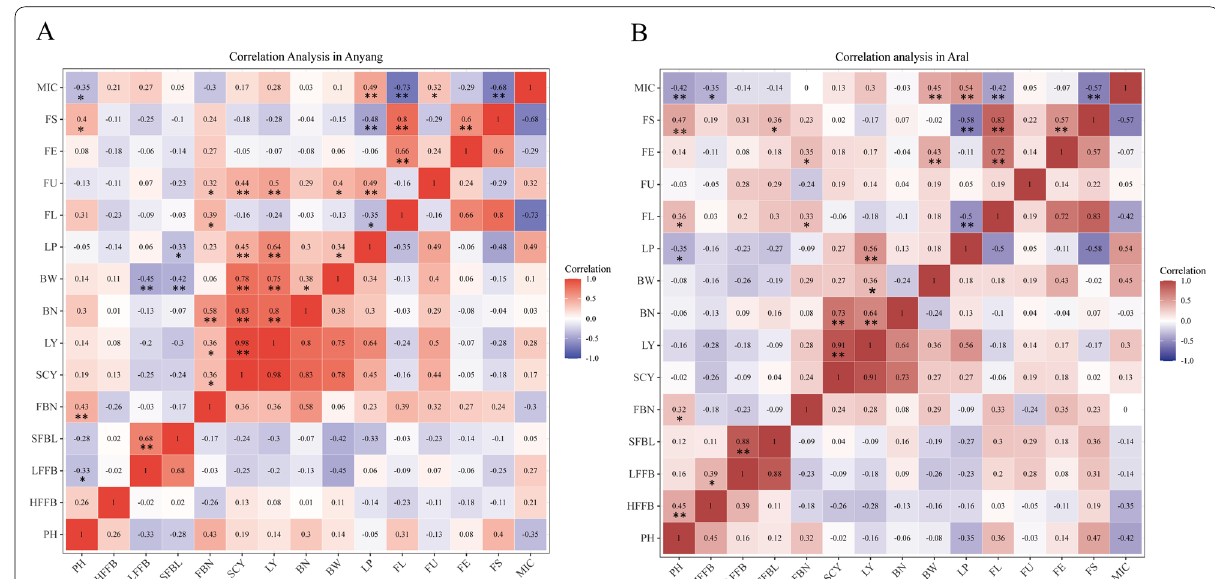
Fig. 2 Correlation analysis of yield, fiber, and agronomic traits in two ecological sites. Correlation analysis among 15 traits in Anyang ( A ) and Aral ( B ). * and ** show significant differences at 0.05 and 0.01 levels,